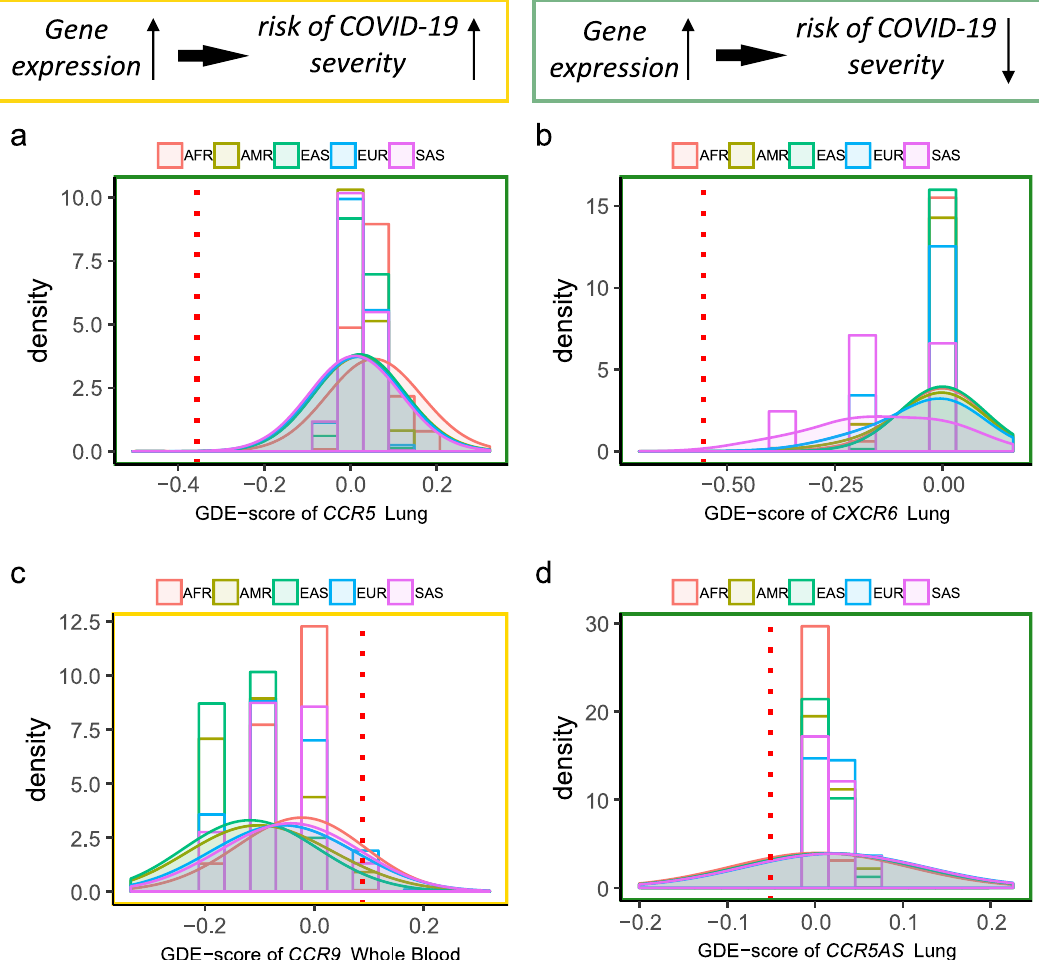
Fig. 5 The distribution of GDE-scores in modern human populations and a carrier of an archaic genomic sequence. We applied the gene expression prediction models in the region to 2504 subjects from the 1000 Genomes project phase 3 to generate tissue-level GDE-scores for these subjects. The distributions of the GDE-scores for the fi ve modern human populations (AFR, AMR, EAS, EUR, and SAS) are displayed for genes with signi fi cant causal effect on either COVID-19 hospitalization or severity (from the Mendelian randomization analyses), including CCR5 ( a ), CXCR6 ( b ), CCR9 ( c ), and CCR5AS ( d ). We also generated a gene ’ s GDE-score in each tissue for the Altai Neanderthal genomic sequence, which is represented here by the red dash line. As illustrated in the top of the fi gure, the direction of effect, as estimated from MR-JTI, for the gene on COVID-19 severity is labeled by color. A yellow or green border denotes that greater genetically determined expression increases or decreases risk of severe COVID-19, respectively. Taking panel ( a ) as an example, compared with modern human genomes, the archaic sequence had a lower GDE-score for CCR5 in lung. Given the Mendelian randomization-based fi nding that decreased expression of the gene increased risk of severe COVID-19, we can infer that the carriers of the archaic genomic segment would be predisposed to developing severe